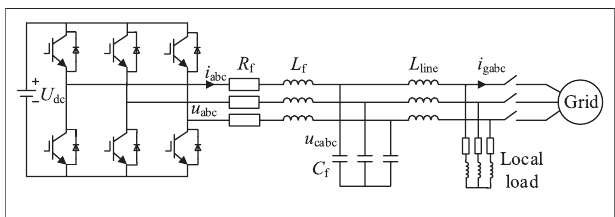
FIGURE 4 | Topology of the